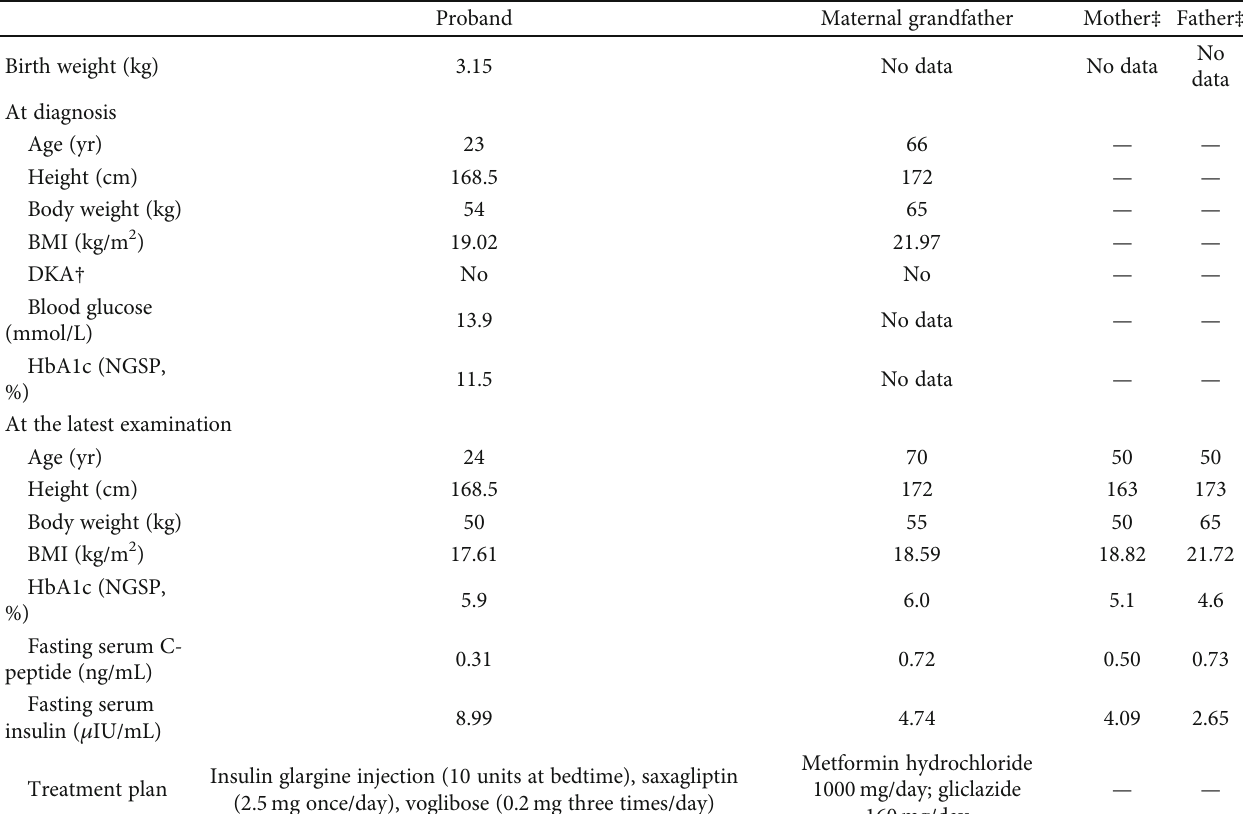
Table 2: Clinical characteristics of the study